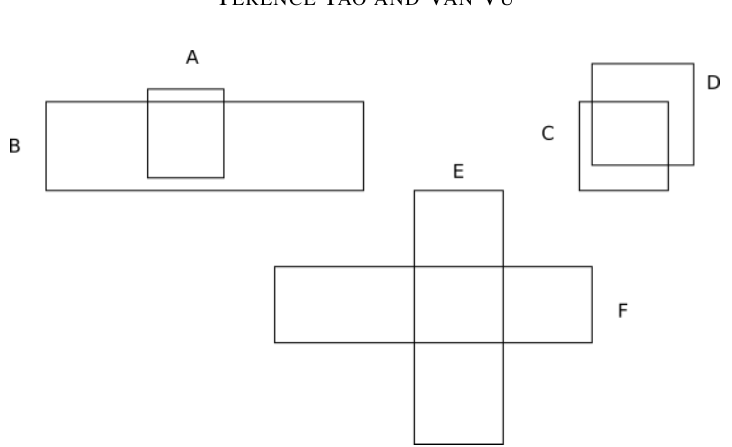
Figure 1: In this schematic (and “not-to-scale”) diagram, B occupies A , but A avoids B ; C and D are commensurate; and E and F are